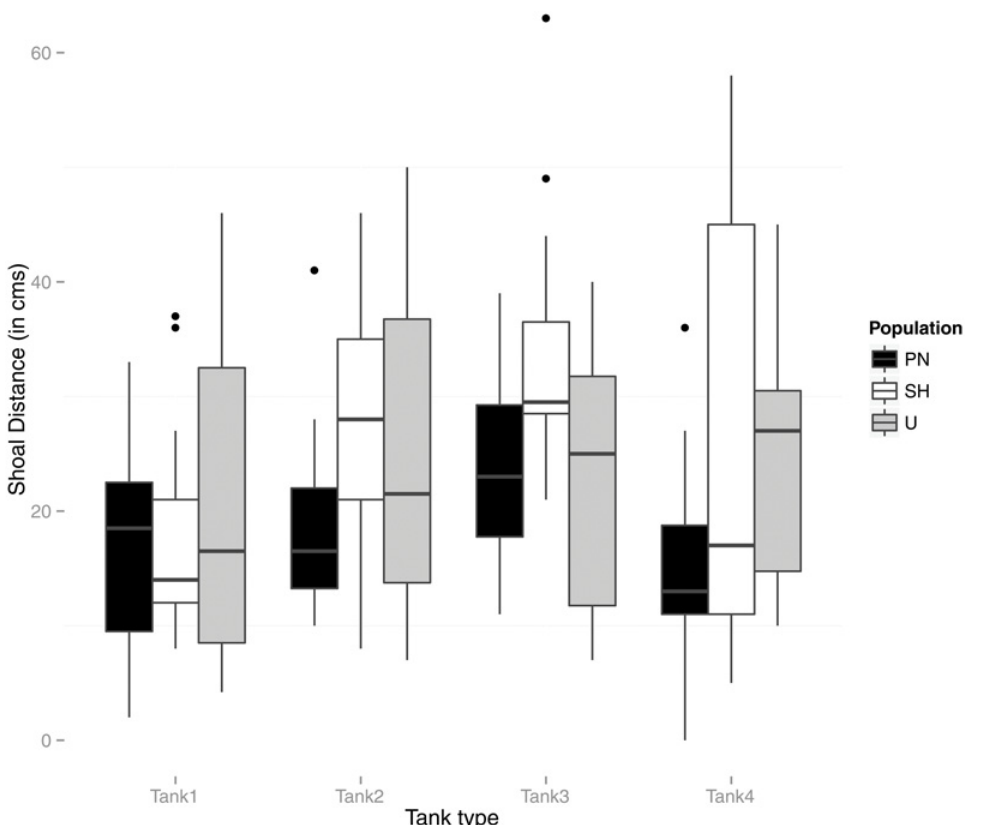
Fig 3. Box-plot representing population-wise measurements of Shoal distance (i.e. average distance of pairs of individuals in each shoal in cms.) in each tank treatment type (tank 1, tank 2, tank 3, and tank 4). Tank 1 (Flow, no vegetation), 2 (No Flow, vegetation), 3 (No flow, no vegetation) and 4 (Flow, Vegetation). Outliers are shown as solid dots.